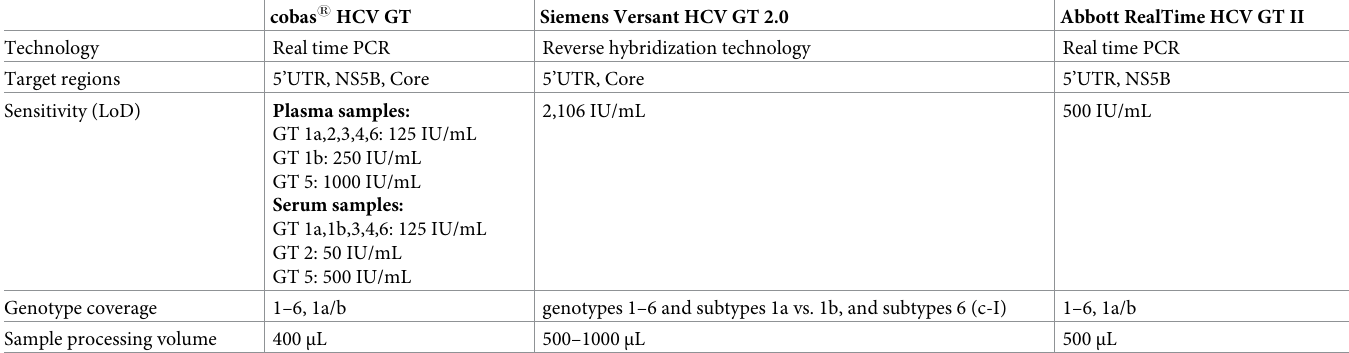
Table 5. Characteristics of the commercially available HCV genotyping